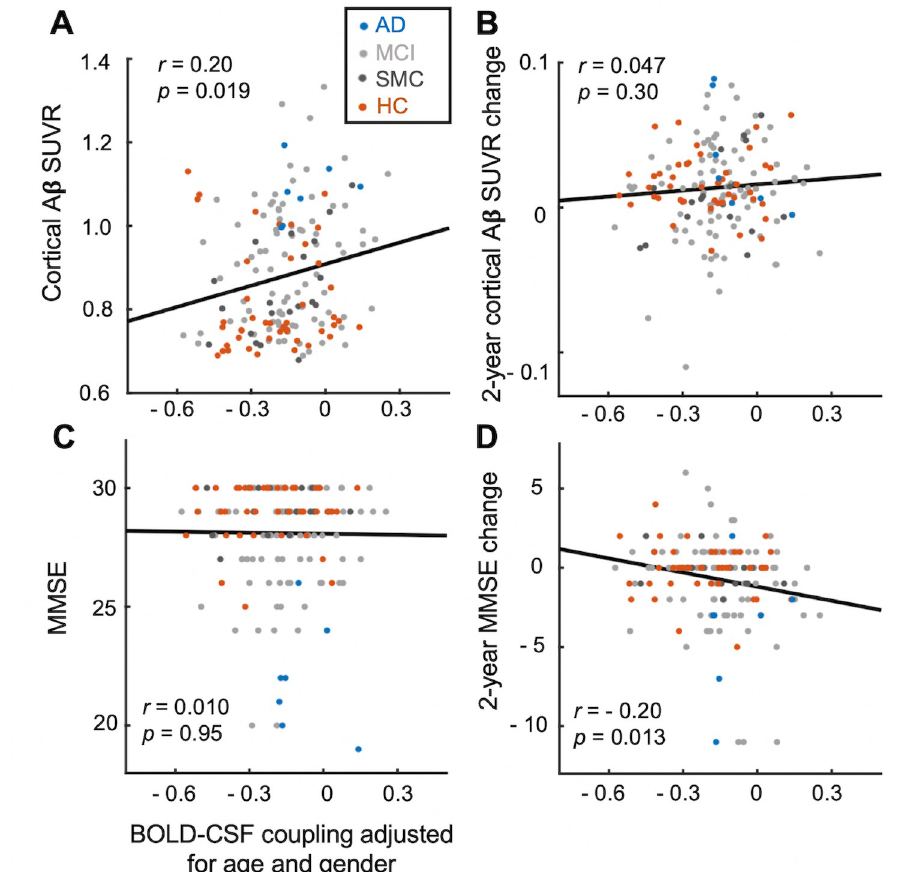
Fig 3. The BOLD–CSF coupling is correlated with the cortical A β and cognitive decline. ( A , B ) The BOLD–CSF coupling adjusted for age and gender is significantly correlated (Spearman’s r = 0.20, p = 0.019, N = 158, the linear mixed model with Satterthwaite method) with the cortical A β SUVRs at baseline ( A ) but not their changes in the following 2 years ( B ). ( C , D ) The BOLD–CSF coupling adjusted for age and gender is significantly correlated (Spearman’s r = − 0.20, p = 0.013, N = 158) with the MMSE score changes in the following 2 years ( D ) but not with its baseline value ( C ). Each dot represents a single session. AD, MCI, SMC, and HC sessions are colored with blue, light gray, dark gray, and orange, respectively. The data underlying this figure can be found in S1 Data. A β , amyloid- β ; AD, Alzheimer disease; BOLD, blood oxygen level–dependent; CSF, cerebrospinal fluid; HC, healthy control; MCI, mild cognitive impairment; MMSE, Mini-Mental State Examination; SMC, significant memory concern; SUVR, standardized uptake value ratio.